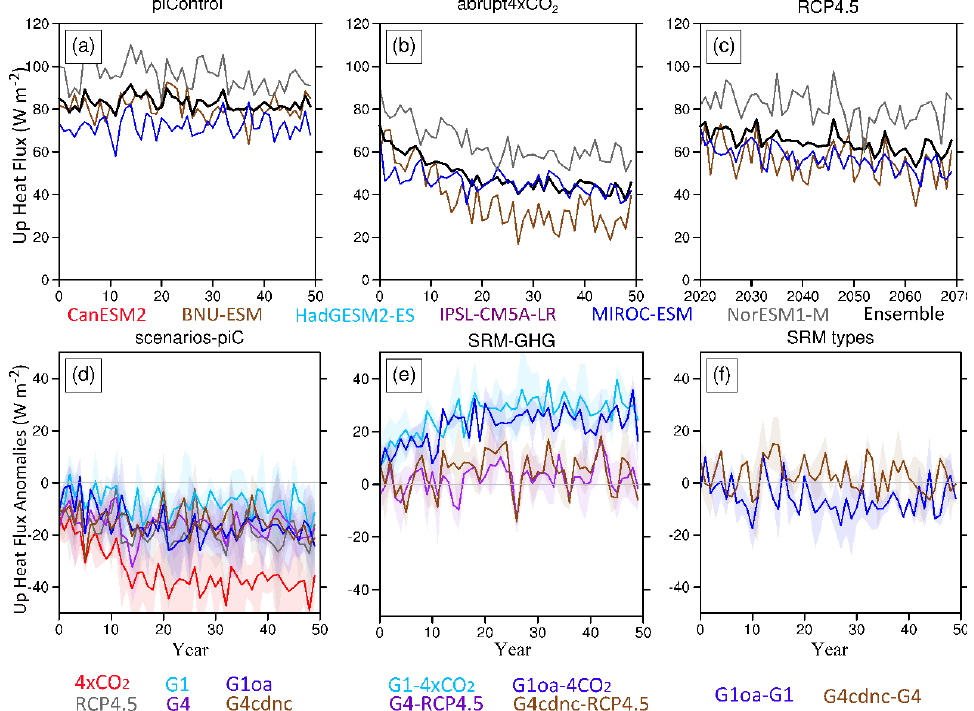
Figure 7. The 11-year running annual means simulated by the six ESMs and their ensemble mean of the upward heat flux (Wm − 2 ) over the 40-year analysis period in the three deep convective regions outlined in Fig. 10 under (a) piControl, (b) abrupt4 × CO 2 and (c) RCP4.5. Panels (d) – (f) show AMOC anomalies, and panels (g) – (i) show the changes relative to the other scenarios: left column (d, g) relative to piControl; middle (e, h) relative to global warming scenarios; right (f, i) relative to other geoengineering scenarios. Colored bands in panels (d) – (i) represent the across-ESM spread. G1oa refers to G1oceanAlbedo, and piC refers to piControl.